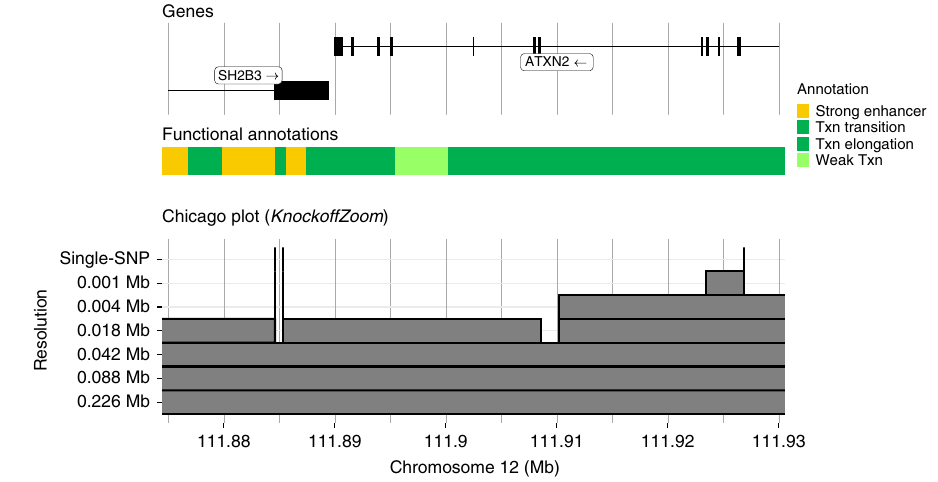
Fig. 5 High-resolution discoveries for platelet count. Visualization of some discoveries made with KnockoffZoom for platelet in the UK Biobank, along with gene positions and functional annotations (ChromHMM 52 , GM12878 cell line) in the LocusZoom 53 style. The three discoveries at single-variant resolution are labeled. Other details are given as in Fig. 1.